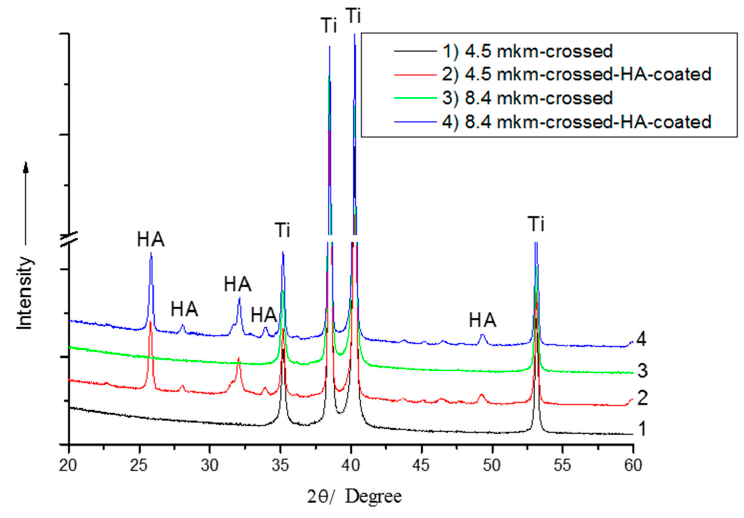
Figure 6. A typical X-ray diffraction (XRD) pattern of HA-coated structured Ti with crossed grooves and a periodicity of 4.5 µm.